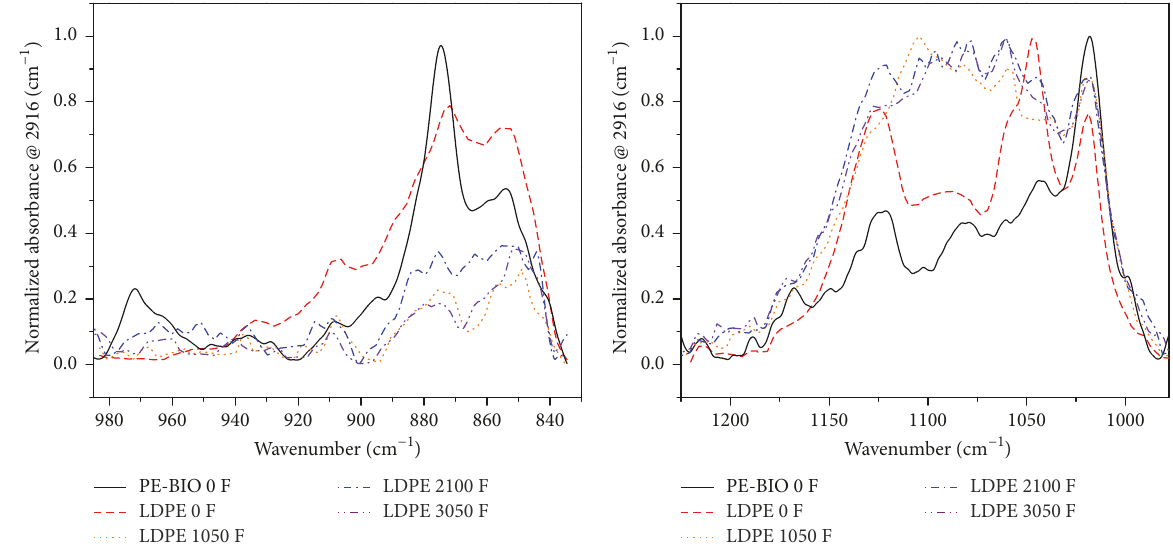
(b) Infrared absorption region of C-O groups in alcohols of LDPE films exposed to different